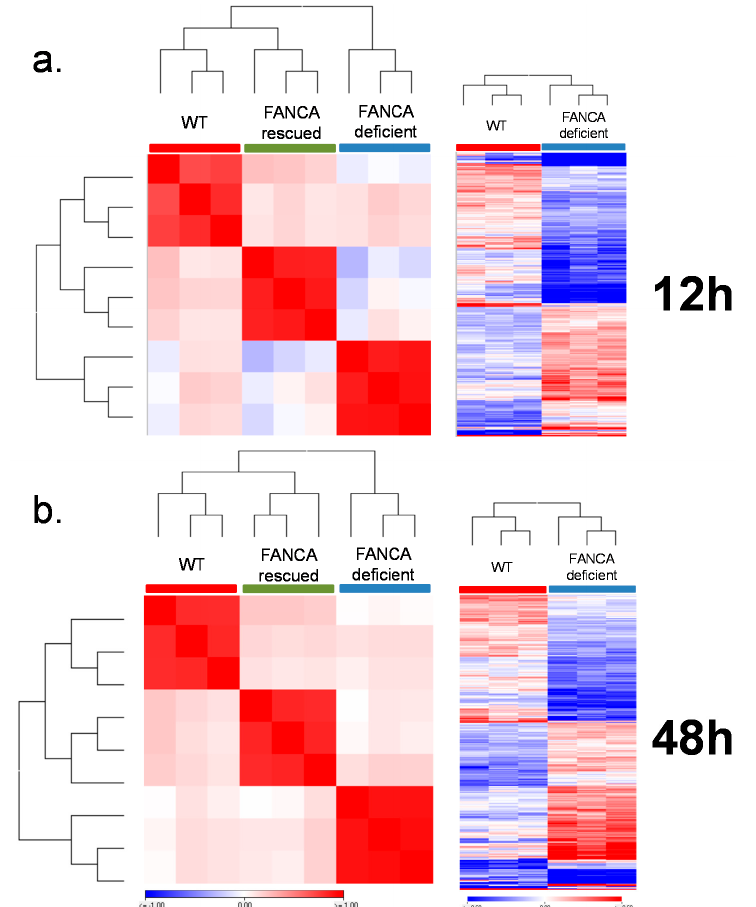
Figure 2. Transcriptional patterns in response to photon, proton and carbon irradiation in wild type and FANCA-deficient HIO derived from healthy and Fanconi anemia individuals. The transcriptional status of genes related to the Fanconi anemia pathway was analyzed in the HIO-106 line 12 ( a ) and 48 h ( b ) post exposure to photon, proton and carbon ions. The Pearson correlation between wt and FANCA rescued and FANCA-deficient cells derived from FA patients clearly distinguishes FANCA-deficient HIO from HIO which express intact FANCA. For each time point gene expression values between healthy HIO and FA-derived 106-HIO (FANCA - deficient and FANCA rescued) were identified ( p < 0.01, ANOVA; n = 1071 12h; n = 1100 48h) which are differentially regulated. All radiation qualities were combined for this analysis.